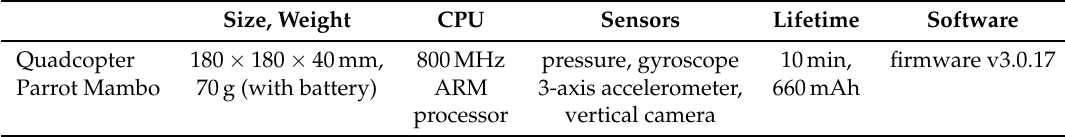
Table 1. Overview of the testbed drone hardware and